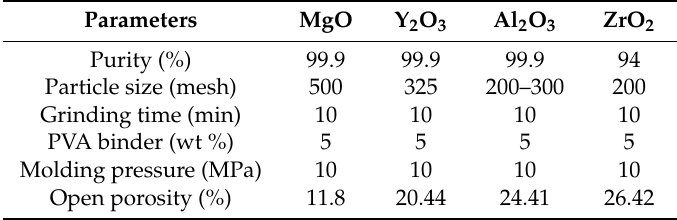
Table 1. Parameters related to substrates with various oxide ceramics.